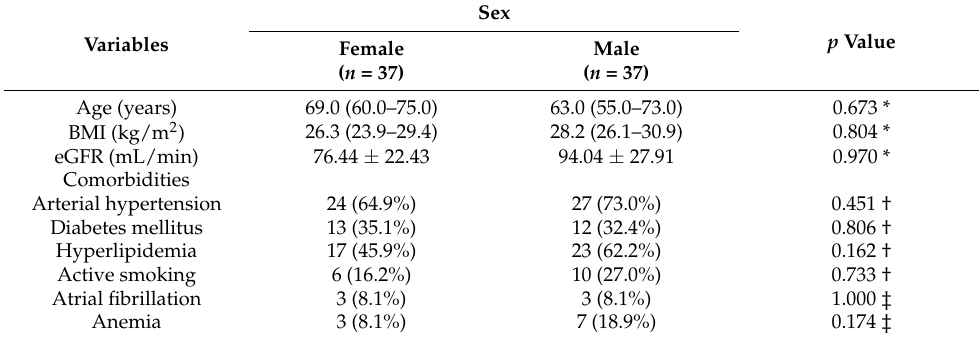
Propensity score matching analysis with a nearest neighbor matching algorithm for age, BMI and eGFR (1:1 allocation and a caliper of 0.01). Data are expressed as number (percent) or median (in- terquartile range). * Mann–Whitney U test; † Chi-square test; ‡ Fisher’s test. Abbreviations: BMI, body mass index; eGFR, estimated glomerular filtration rate.